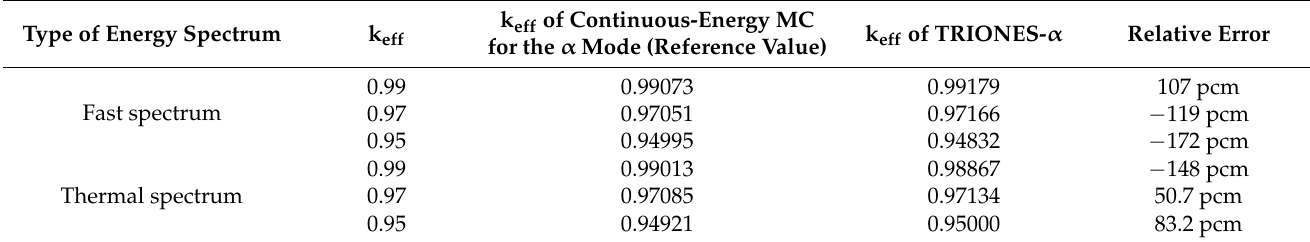
Table 5. The results of the verification of the homogenized group constants for the fast/thermal spectra of the ADSR in the α